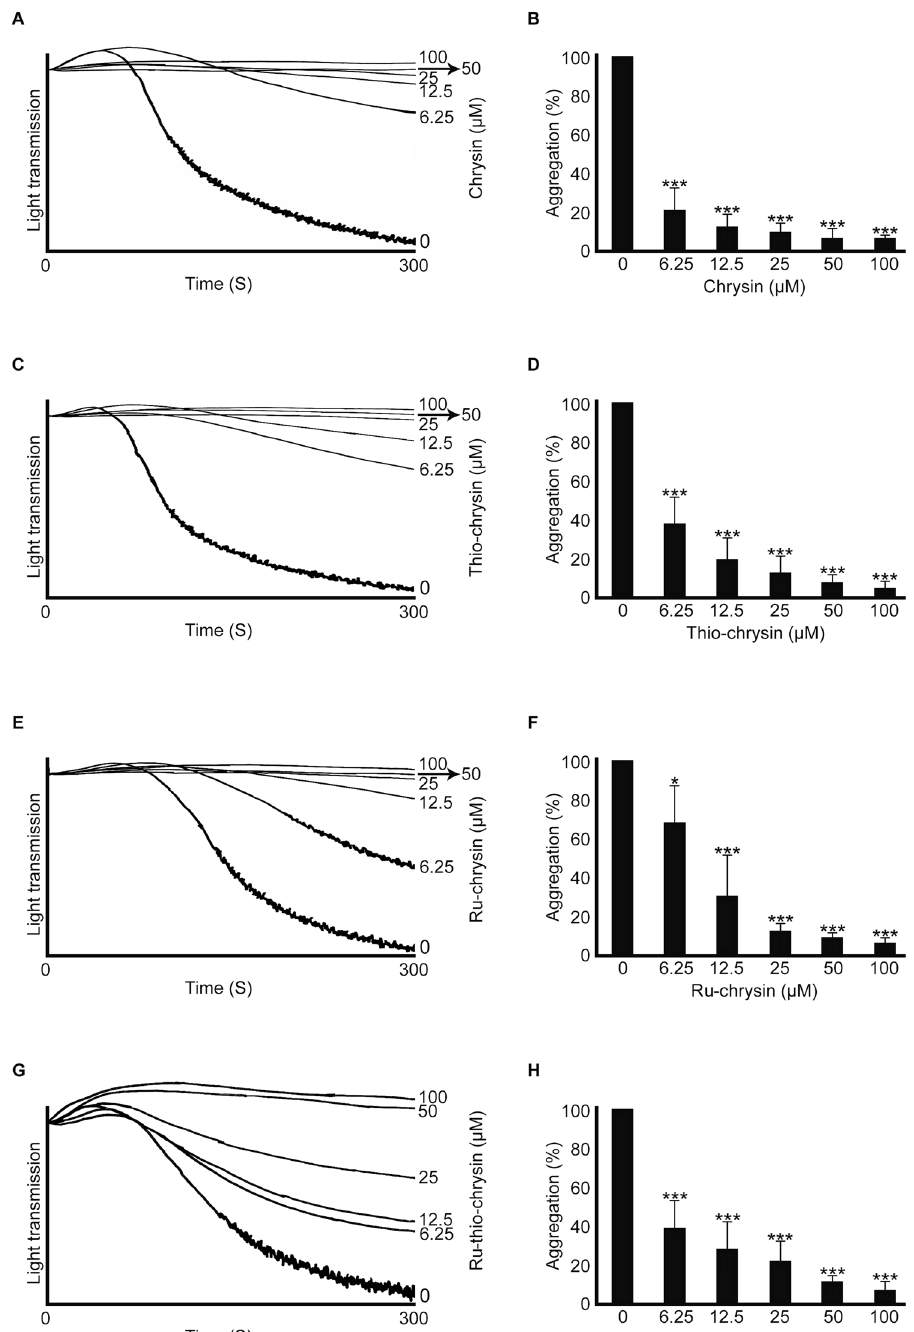
Figure 2. Effects of chrysin and its derivatives in washed platelet aggregation. Human washed platelets were incubated with a vehicle control [0.1% (v/v) DMSO] or different concentrations of chrysin ( A , B ), thio-chrysin ( C , D ), Ru-chrysin ( E , F ) and Ru-thio-chrysin ( G , H ) for 5 minutes prior to the addition of 0.5 μ g/mL CRP-XL and the platelet aggregation was monitored for 5 minutes by optical aggregometry. The aggregation traces shown are representative of three separate experiments. The maximum aggregation obtained with vehicle control at 5 minutes was taken as 100% to calculate the level of aggregation for chrysin and its derivatives-treated samples. Cumulative data represent mean ± S.D. (n = 3). * Indicates significance with respect to controls and p values shown ( * p < 0.05, and *** p < 0.001) are as calculated by one-way ANOVA using Graphpad